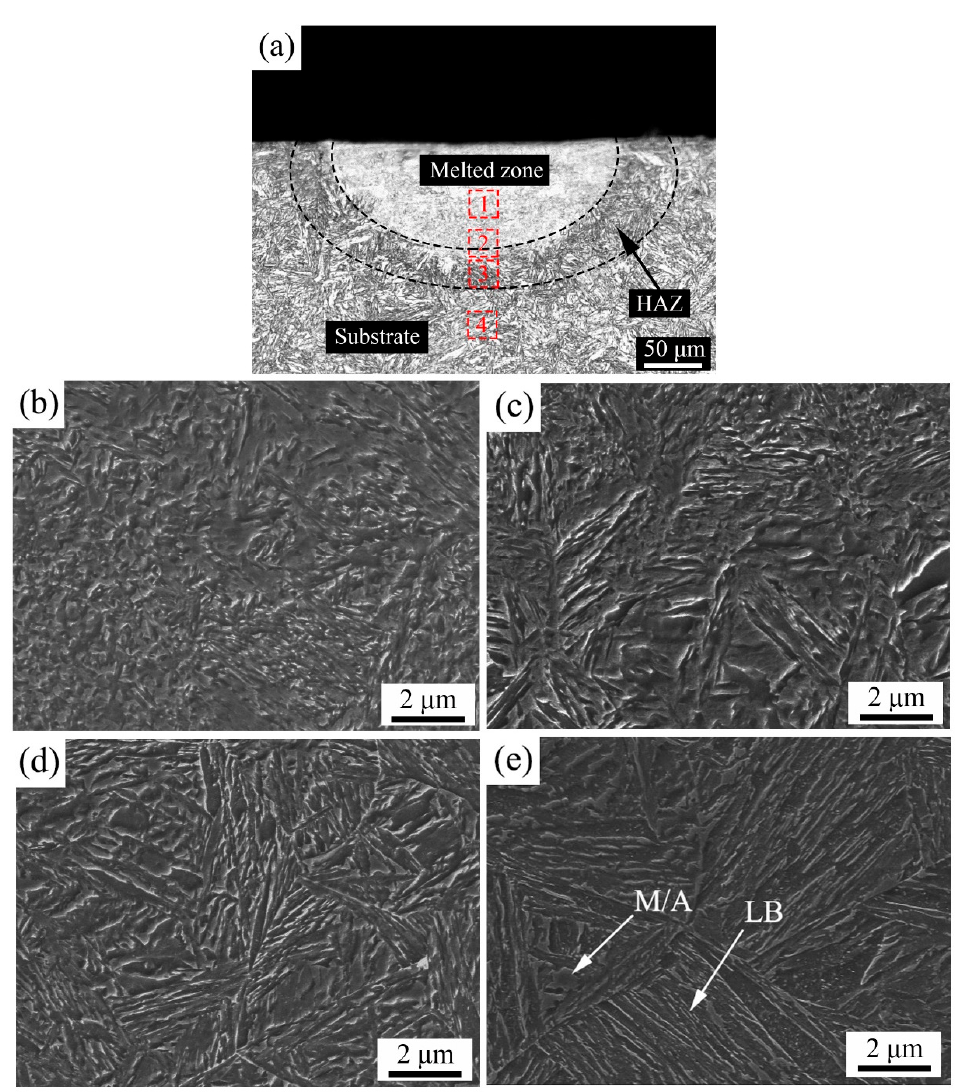
Figure 5. Microstructure and morphology of the laser single-pass modified layer. ( a ) cross-sectional panorama; ( b )–( e ) group morphology corresponding to the 1–4 positions in ( a ).